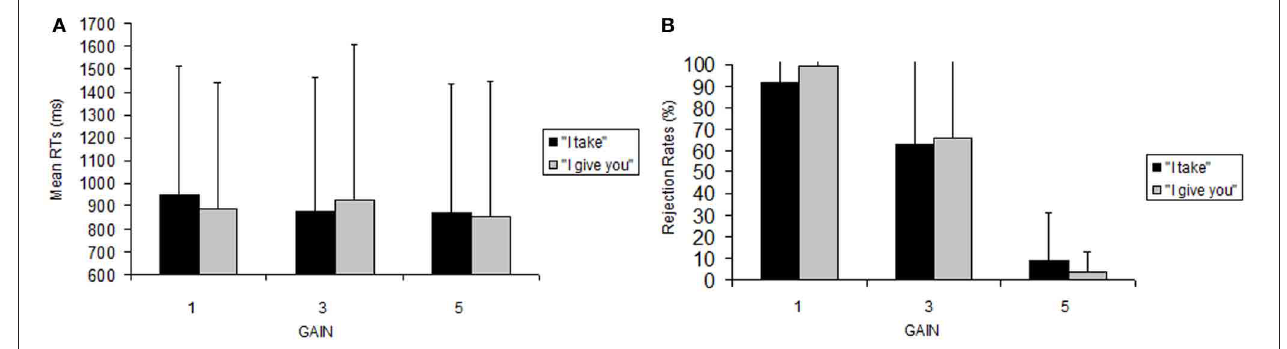
FIGURE 1 | Behavioral data. Reaction time (A) and accuracy (B) data for performing the UG task. Error bars indicate standard error